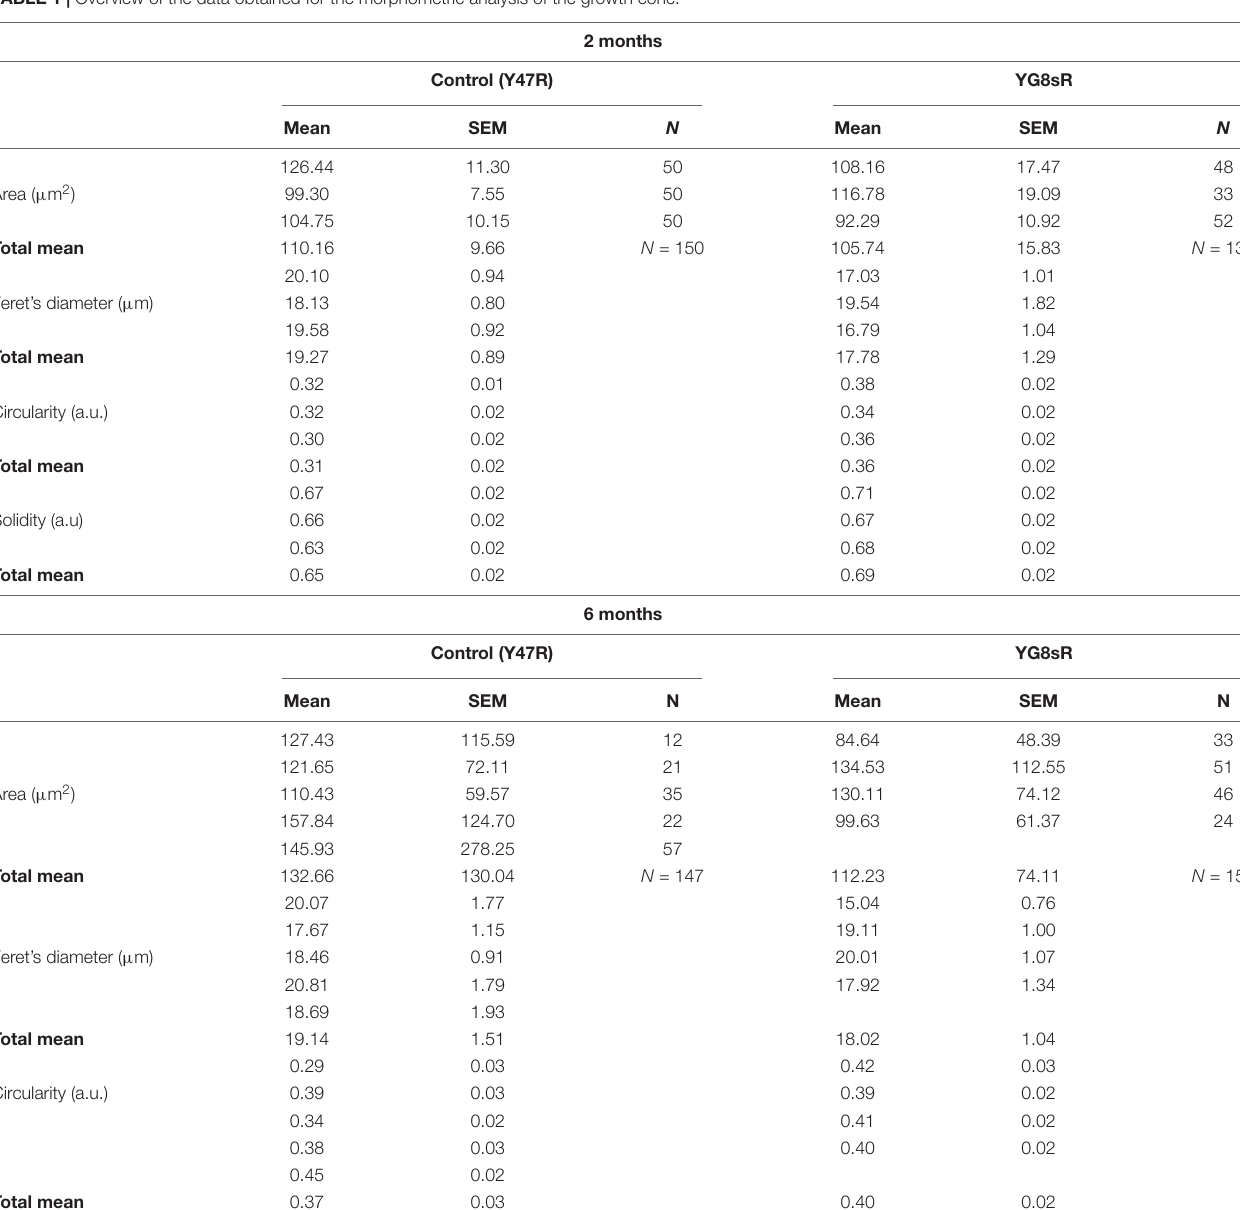
TABLE 1 | Overview of the data obtained for the morphometric analysis of the growth